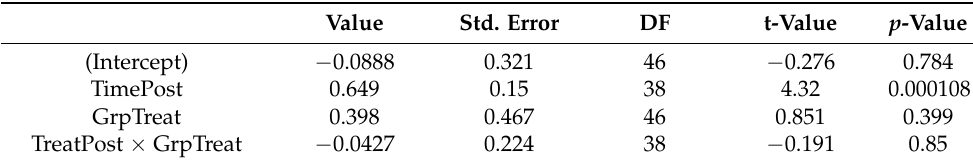
Figure 4. Box-plots of the General Strength Score (GS) calculated from the strength data of study A grouped by supplementation (Ctrl: control group; Treat: treatment group). Pre: measurement before training intervention; Post: measurements after training intervention. GS corresponds to the 1st principal component extracted from the strength data. See text for detailed explanation of the score. The box-plots indicate minima, 1st quartiles, medians, second quartiles and maxima, respectively. Maxima or minima falling beyond the median ± 1.5 times the respective interquartile range (“outliers“) are placed outside the whiskers. Dashed lines correspond to repeated measurements of the same subjects. Table 4. LME parameters fitted to GS data.